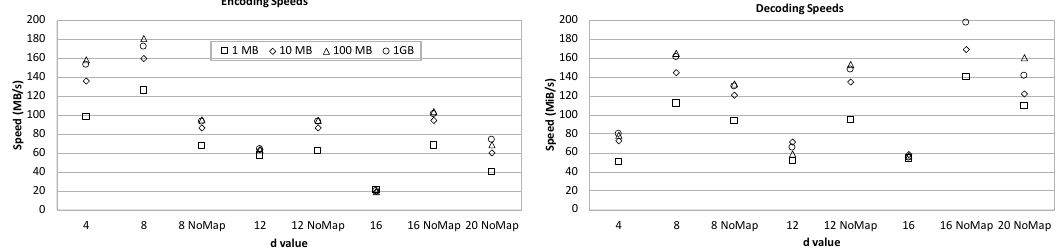
Figure 3. NPF encoding/decoding speed in megabytes per second on different file sizes with different d values. Note that “NoMap” means no look-up table is